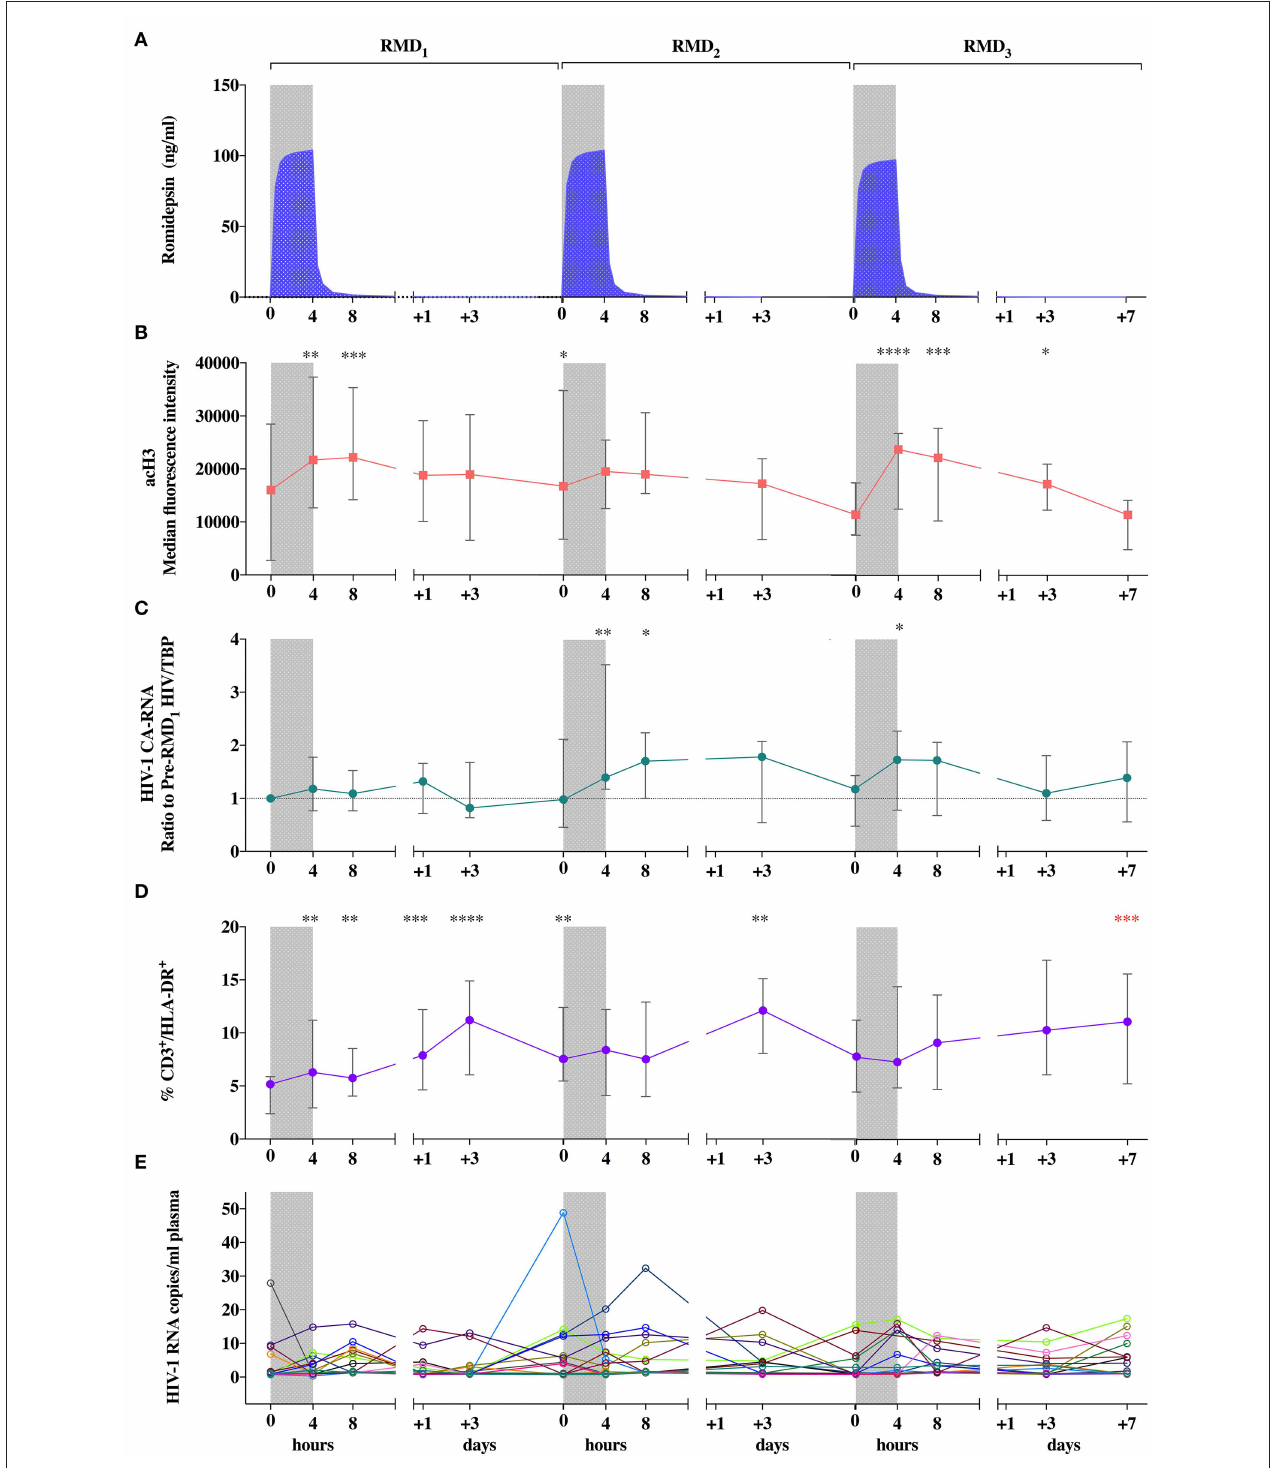
FIGURE 2 | Pharmacokinetic and pharmacodynamic effects of RMD. (A) Mean individual predictions of RMD plasma concentrations. (B) Levels of histone H3 acetylation in peripheral lymphocytes. (C) Viral transcription levels expressed as changes from pre-RMD 1 levels of cell-associated HIV-1 RNA in peripheral CD4 + T-cells. (D) Levels of T-cell activation (CD3 + /HLA-DR + cells). (E) individual determinations of pVL. Median of frequencies and IQR (error bars) are represented. Wilcoxon signed-rank p -values compare each represented time point with the corresponding values preceding each RMD administration. * p < 0.05. ** p < 0.01. *** p < 0.001 and **** p < 0.0001. The p value resulting from the comparison between the value at day 0 of RMD 1 and 7 days after RMD 3 is shown in red.